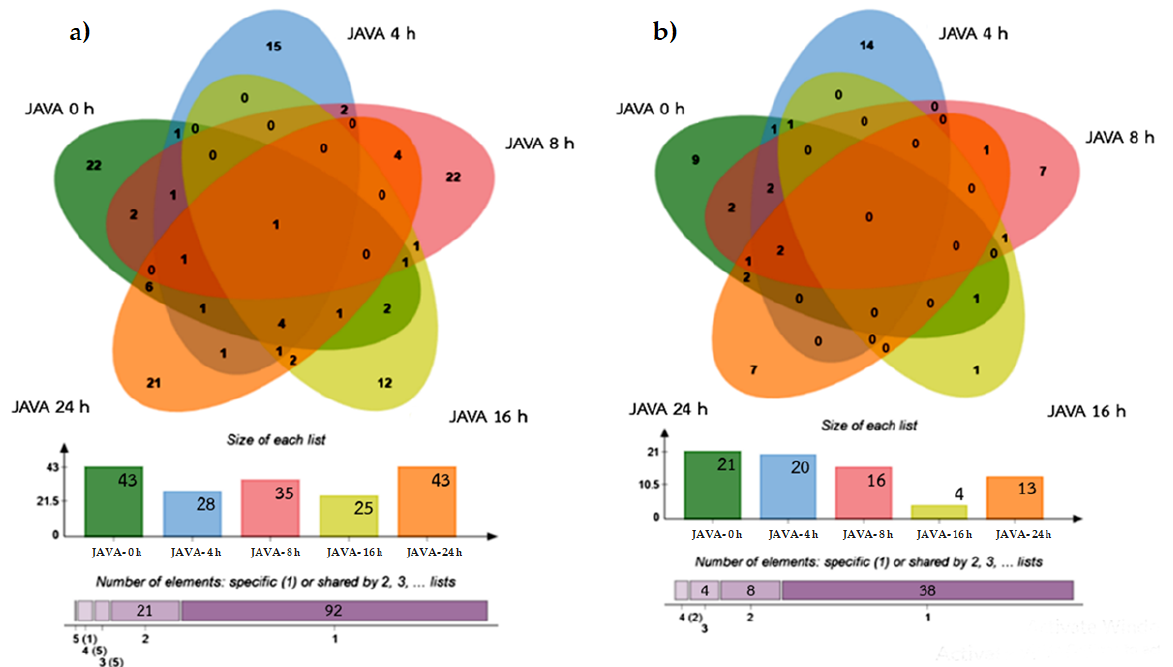
Figure 6. Venn diagram showing the proteins identified from C. neoformans in different time points after r-javanicin treatment in three biological replicates. The distribution of identified proteins in each condition ( a ) and the number of proteins classification based on protein function ( b ) are shown. Top part shows the protein counts of shared and un-shared regions of javanicin treated C. neoformans (JAVA) at 0, 4, 8, 16 and 24 h. Charts on the lower left and right show the size of protein clusters in each time point from 0 (green), 4 (blue), 8 (pink), 16 (yellow) and 24 h (orange), respectively. The bottom part is the cumulative numbers of specific (purple) and shared proteins (light purple) based on Venn diagram.